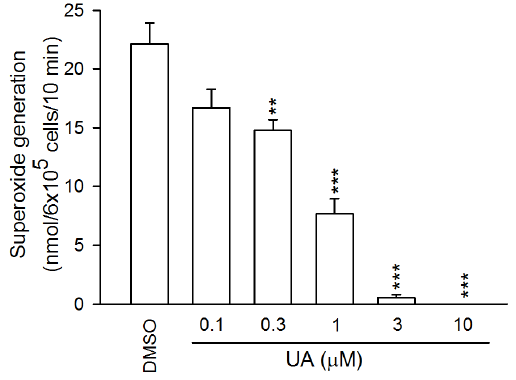
Figure 1. Effects of ursolic acid (UA) on superoxide anion generation in N-formyl-methionyl-leucyl-phenylalanine (FMLP) in the pre-priming with cytochalasin B (FMLP/CB)-activated human neutrophils. Data are shown as mean 6 SEM (n=5). * p , 0.05, ** p , 0.01, *** p , 0.001 compared to the control.